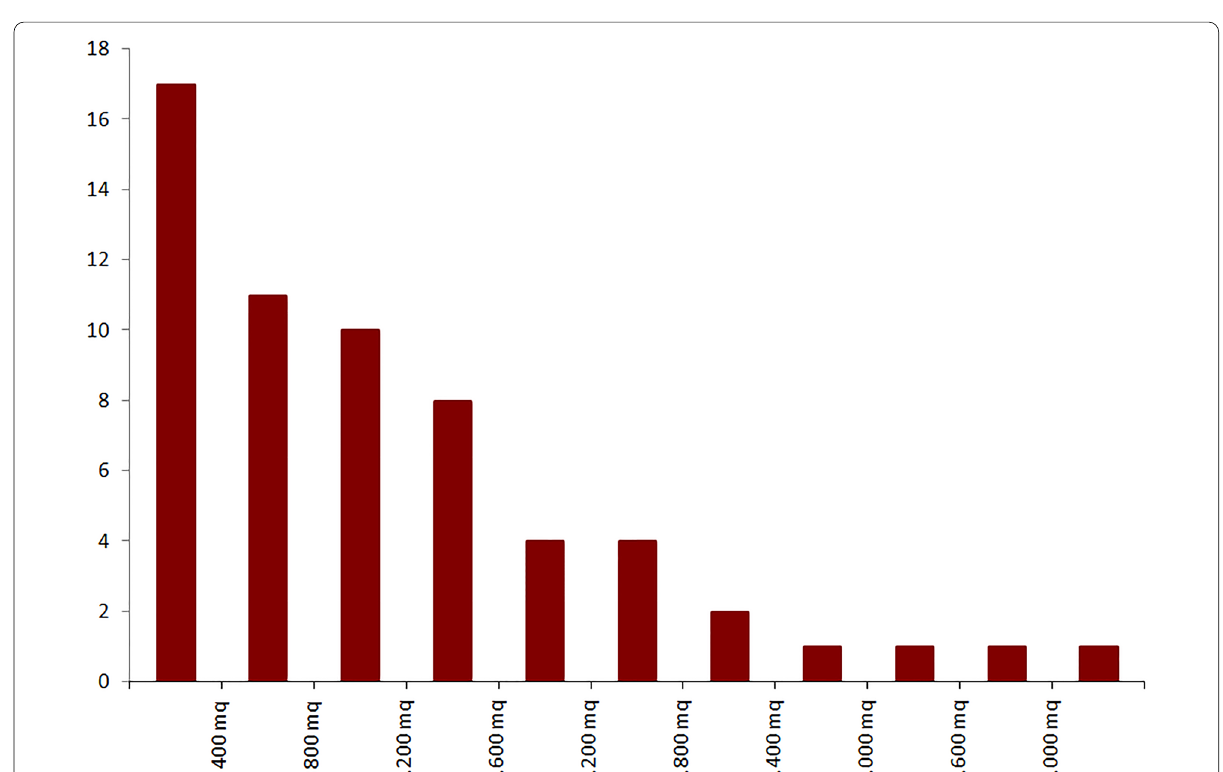
Fig. 7 Number of companies that have made use of DRs in construction practices per square meter of total gross floor